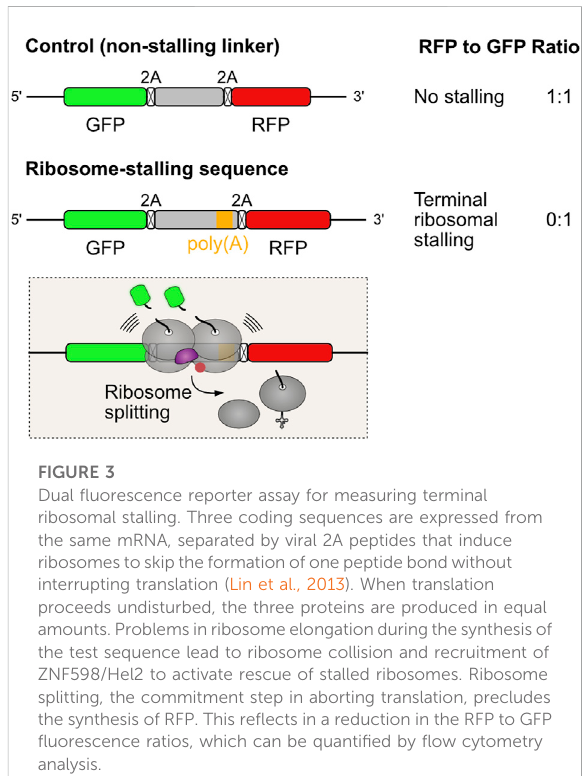
FIGURE 3 Dual fl uorescence reporter assay for measuring terminal ribosomal stalling. Three coding sequences are expressed from the same mRNA, separated by viral 2A peptides that induce ribosomes to skiptheformation ofonepeptidebondwithout interrupting translation (Lin et al., 2013). When translation proceeds undisturbed, the three proteins are produced in equal amounts.Problemsinribosomeelongationduringthesynthesisof the test sequence lead to ribosome collision and recruitment of ZNF598/Hel2 to activate rescue of stalled ribosomes. Ribosome splitting, the commitment step in aborting translation, precludes the synthesis of RFP. This re fl ects in a reduction in the RFP to GFP fl uorescence ratios, which can be quanti fi ed by fl ow cytometry